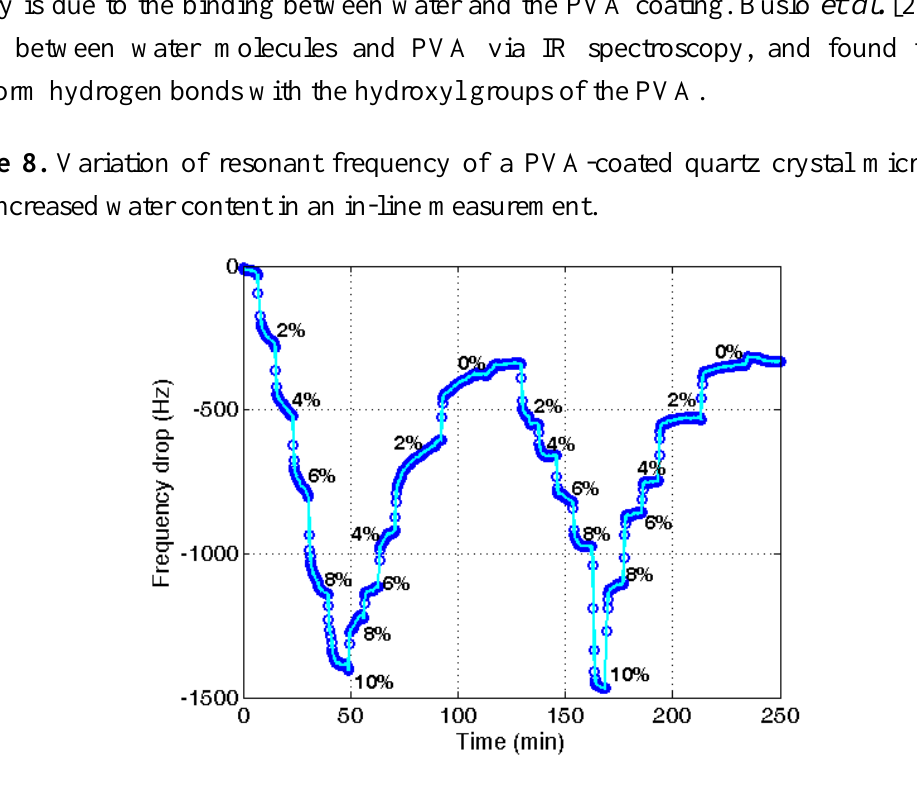
Figure 9. Relationship between water content and resonant frequency shift of a PVA-coated quartz crystal microbalance with increased water content in an in-line